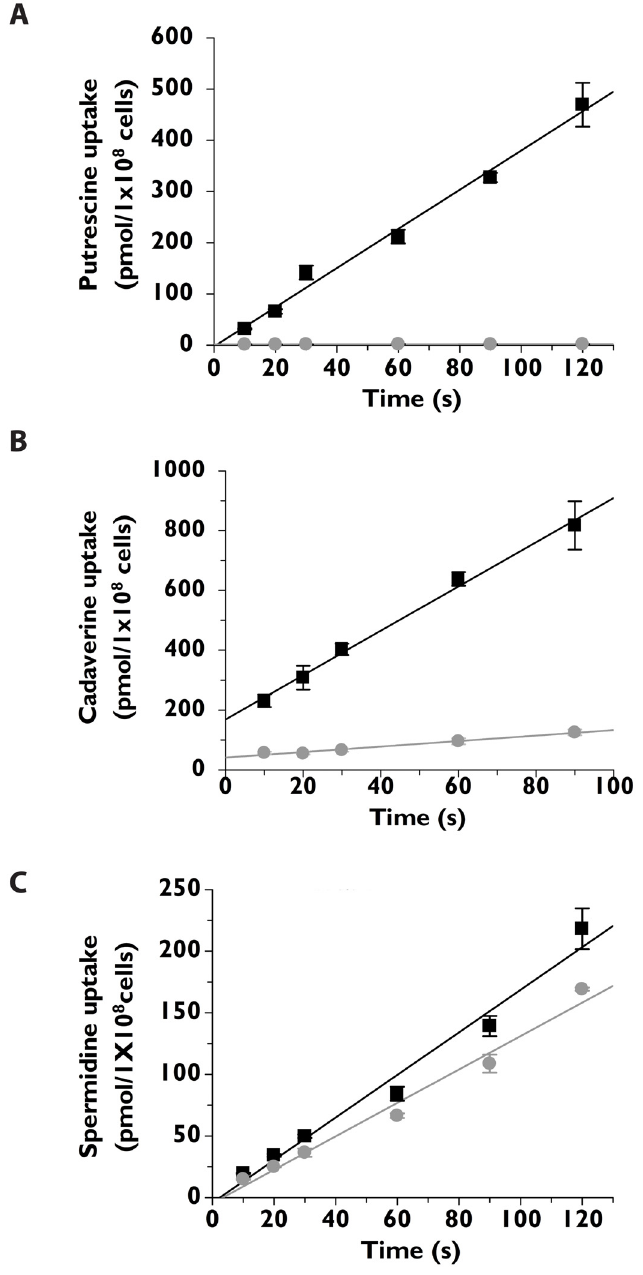
Fig 2. Diamine and polyamine transport by wild type and Δ tcpot1 epimastigotes. The abilities of wild type ( & ) and Δ tcpot1 (grey dot) epimastigotes to transport 1 μ M (A) [ 3 H]putrescine, (B) 9 μ M [ 14